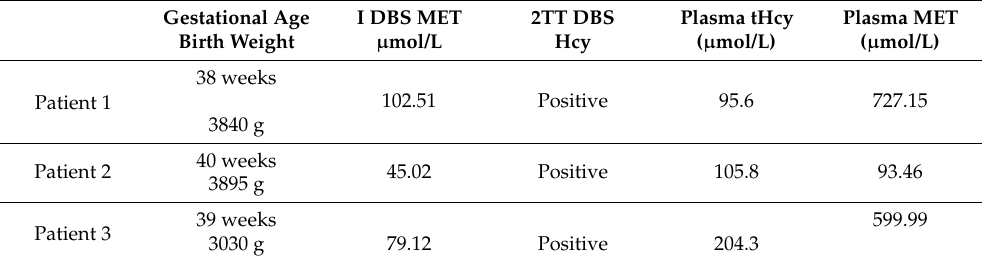
Table 1. Laboratory values of the first DBS and diagnostic confirmation. Plasma HCY normal value weight > 1800 g. DBS Hcy: positive > 5 µ